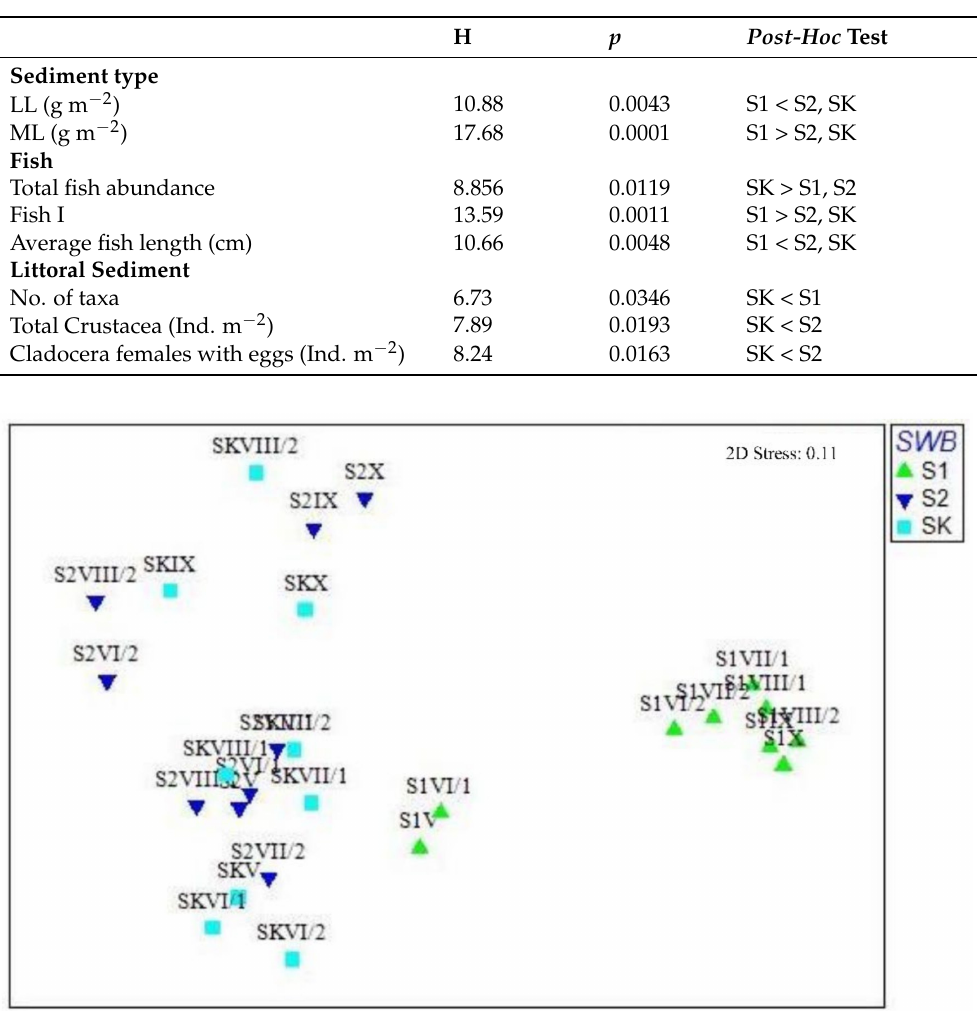
Table 1. Significant differences (Kruskal–Wallis test, p < 0.05) in the sediment type and traits of fish, zooplankton, and planktonic crustaceans in the littoral sediment among the study sites (S1, S2, and SK).